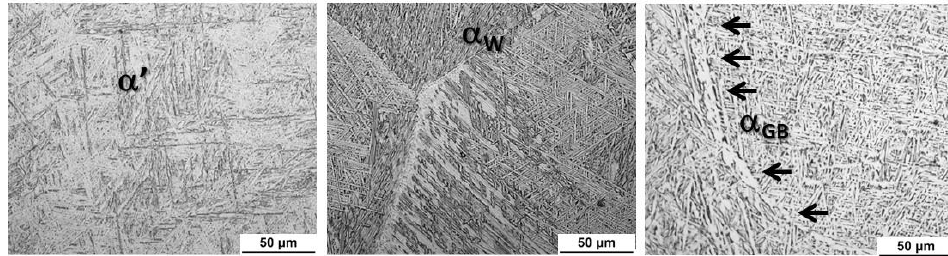
Figure 12. Heterogeneity of microstructures detected in different zones of the weld beads ( α ’: martensite, α W : Widmanstätten α phase, α GB : α phase in the grain boundary). This mixed structure is also appreciable due to the presence of basket weave Wid- manstätten structure and colonies of α in the same grain as shown in Figure 13.